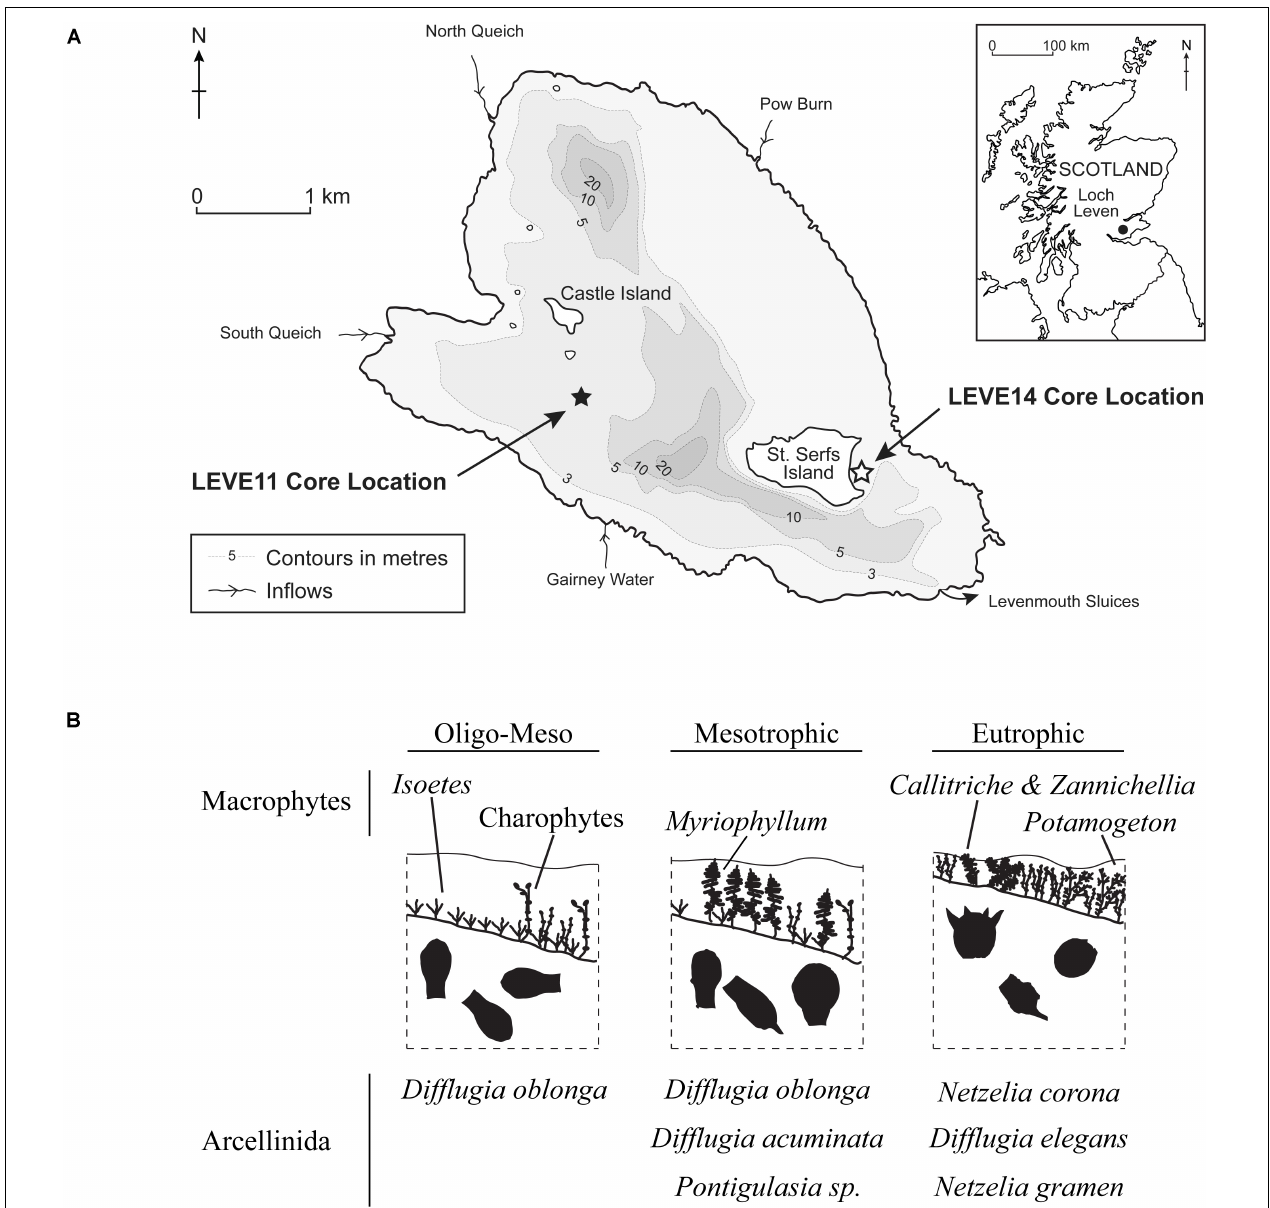
FIGURE 1 | (A) Map showing the location and bathymetry of Loch Leven and the locations of sediment cores from previous studies of plant macrofossils (LEVE14) (Salgado et al., 2010), testate amoebae (LEVE14) (Prentice et al., 2018) and diatoms (LEVE11) (Bennion et al., 2012). Core LEVE14 is used in this study. (B) Three phases of progressive nutrient enrichment as inferred from plant macrofossils (Salgado et al., 2010) and testate amoeba (Prentice et al., 2018).